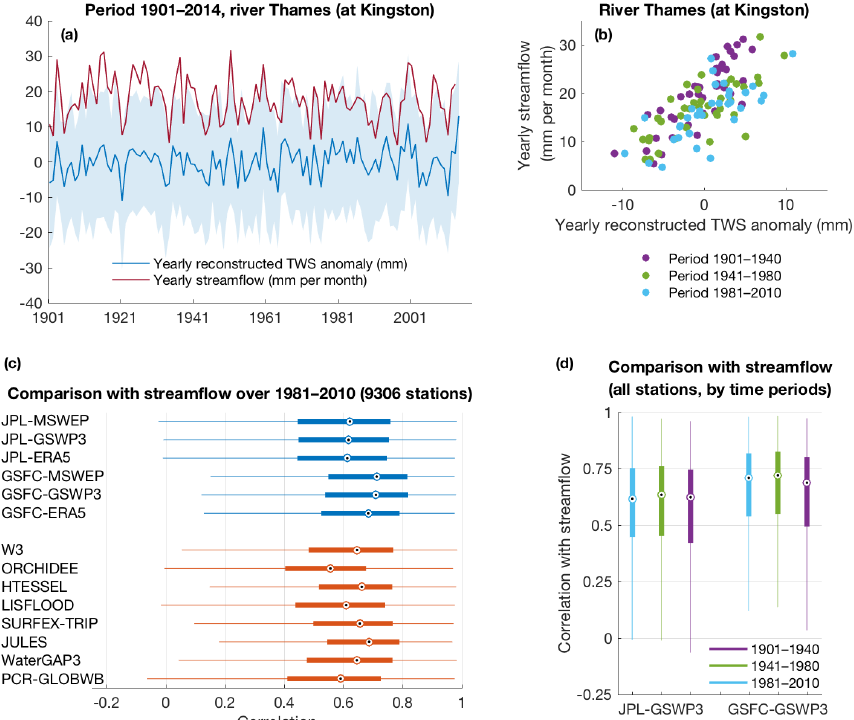
Figure 13. (a) Comparison between century-long measurements of streamflow and the TWS anomalies reconstructed at this location (GSFC- GSWP3 dataset). (b) Scatter plot of the data in (a) , by time period. (c) Global box plots of the performance of GRACE-REC and WRR2 models when compared with yearly streamflow anomalies. (d) Global box plots of the performance of the JPL-GSWP3 and GSFC-GSWP3 products when compared with yearly streamflow anomalies, by time period ( n = 1274, 8065, and 9306 for 1901–1940, 1941–1980, and 1981–2010